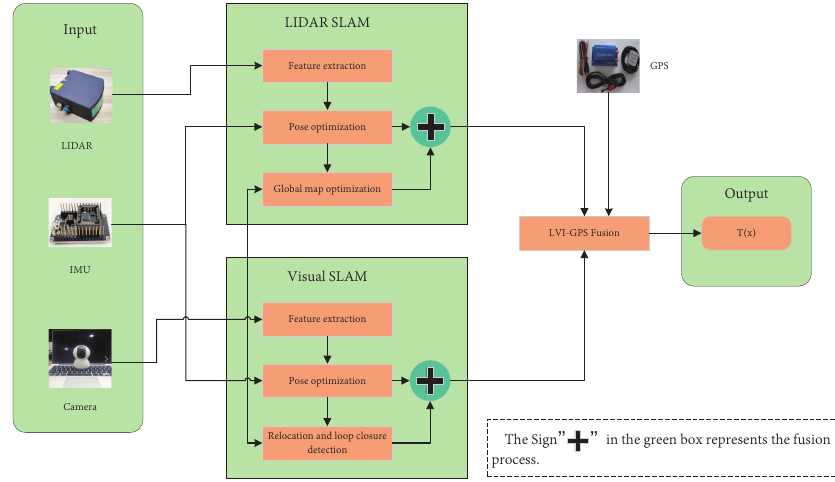
Figure 20. The framework of LVI-SLAM–GPS